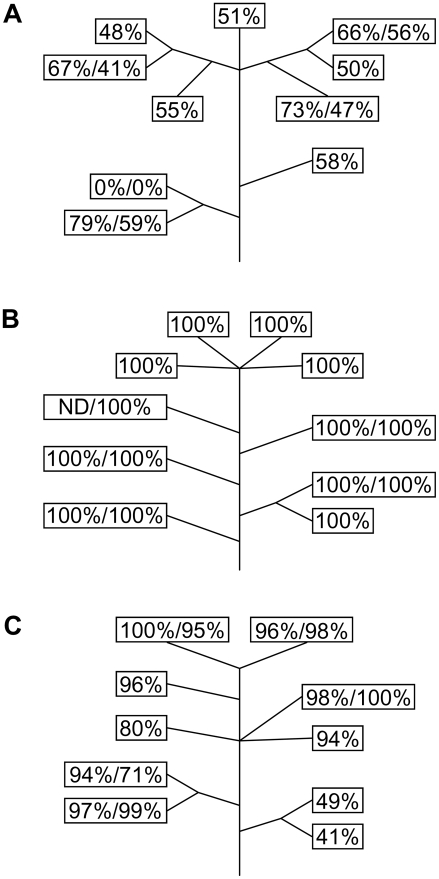
Analysis of instability in homozygous descendents of kr2.3 (A), kr2.7 (B) and kr2.10 (C).Each box represents a seed capsule. Where one number is shown, it indicates the percentage of kanamycin resistant progeny from a backcross to male wildtype. Where two numbers are shown, that flower was used for both self-fertilisation and backcrossing to female wildtype. The numbers indicate the percentage of kanamycin resistant progeny from self-fertilisation and backcrossing respectively. Each number represents approximately 100–150 seeds which were tested for kanamycin resistance. Lines represent branches (not to scale) and are included to show the branching pattern of the plants from which individual seed capsules were progeny tested. ND not determined.